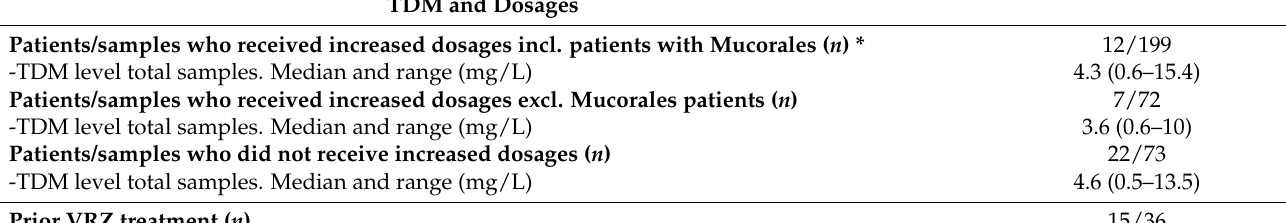
Table 2. TDM values and tolerance data.